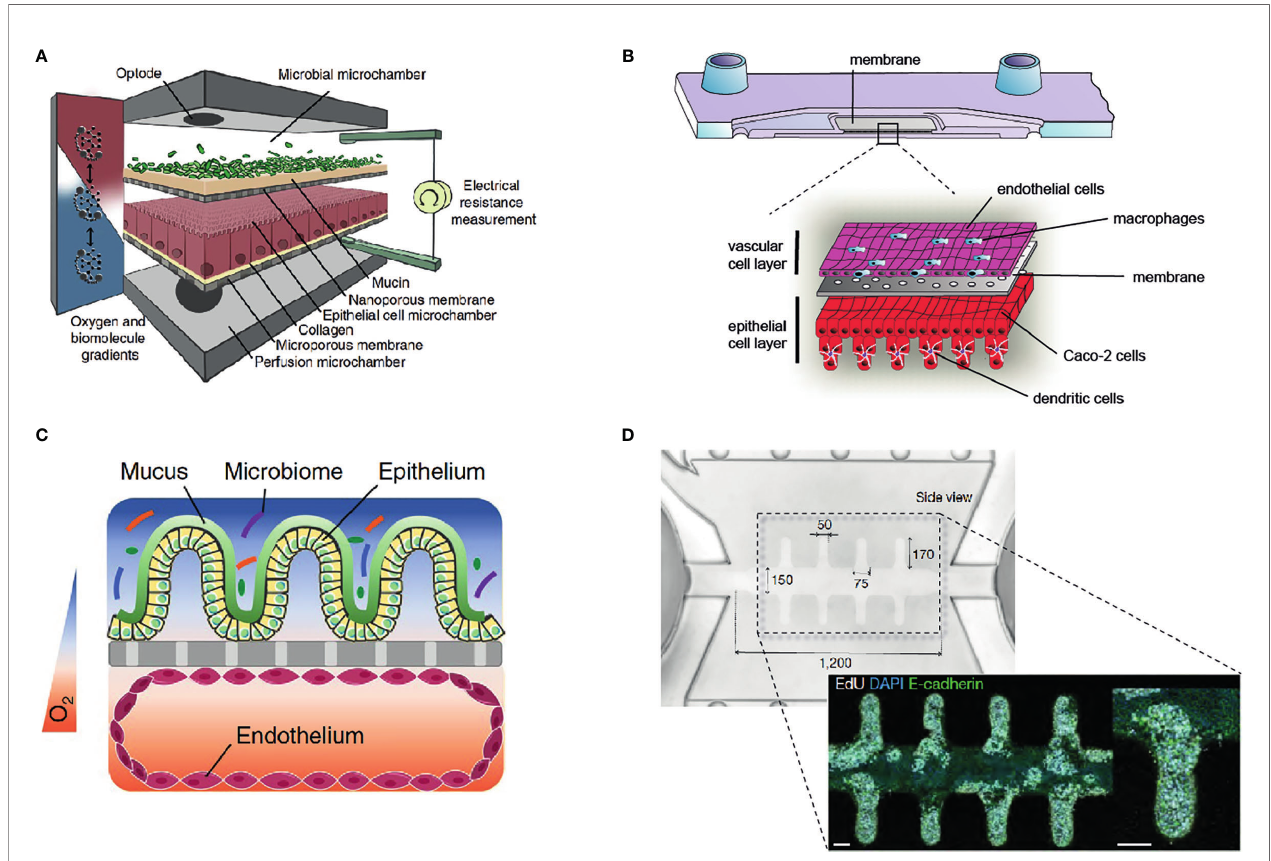
FIGURE 2 | Overview of selected gut-on-chip models to study host-microbiota interaction in vitro . (A) The HuMiX gut-on-chip model allows the co-culture of anaerobic bacteria with an epithelial cell layer (68) (Creative Commons CC BY license). (B) Immunocompetent, multilayered gut-on-chip model comprising endothelial cells, epithelial cells, macrophages, and dendritic cells (12) (Copyright © 2019 Elsevier Ltd. All rights reserved). (C) Gut-on-chip model with oxygen tension gradient for the culture of a complex microbiome up to three days (11) (Copyright © 2019, The Author(s), under exclusive license to Springer Nature Limited). (D) Mini-intestine formed by organoid-derived epithelial cells, guided in growth by a perfused 3D hydrogel scaffold (37) (Copyright © 2020, The Author(s), under exclusive license to Springer Nature